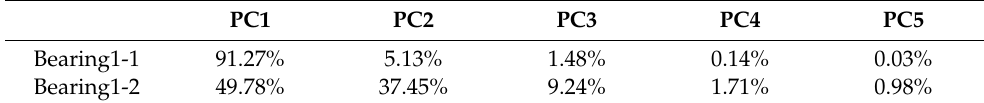
Table 2. Accounts for variability of principal components of learning